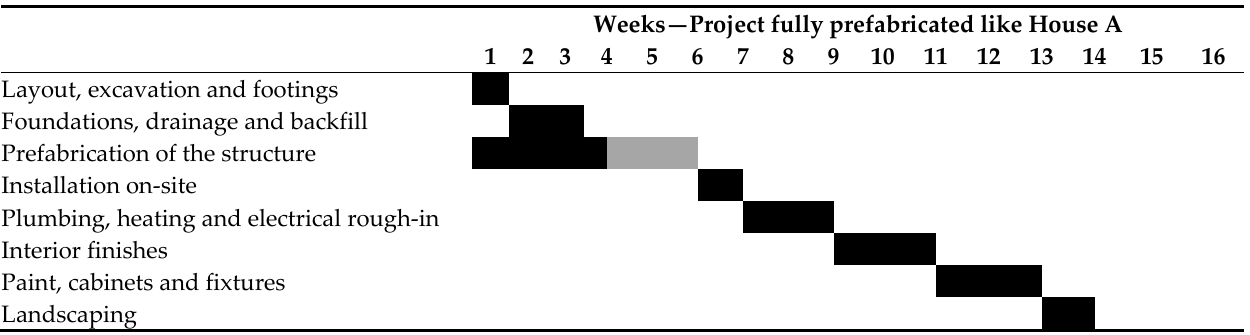
Figure 16. Schedule for a single-family residential project as proposed and sourced by: Canada Mortgage and Housing Corporation (CMHC) [36].